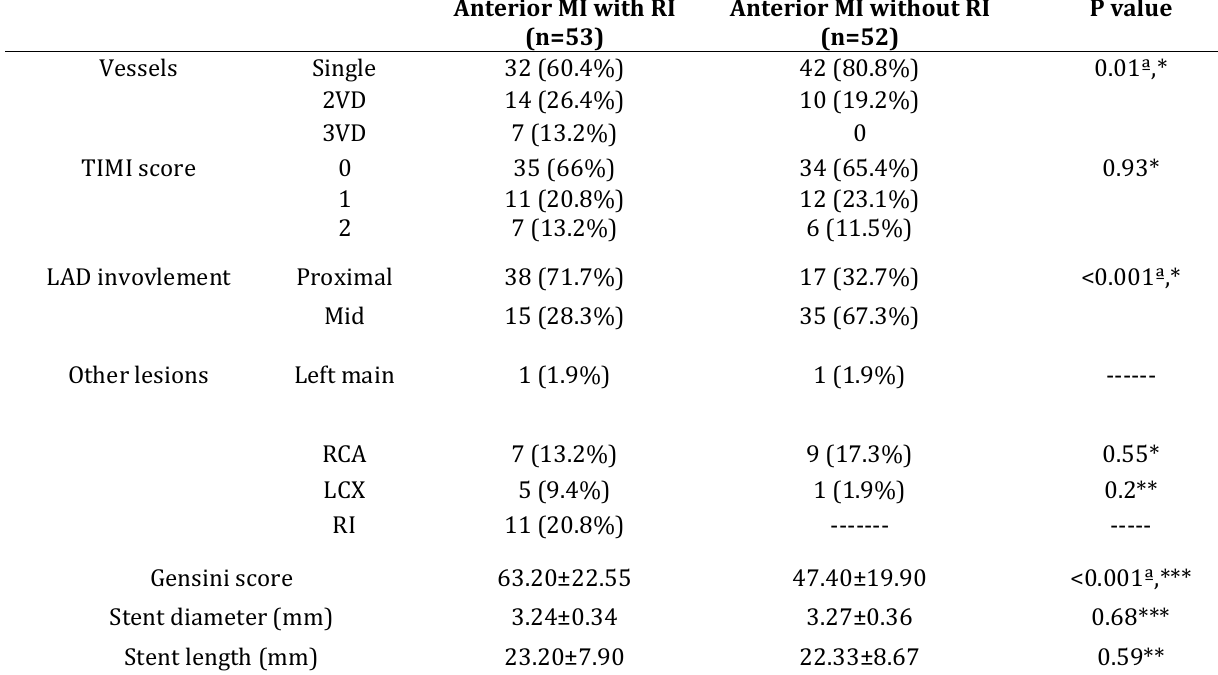
Table 2. Angiographic 8indings between